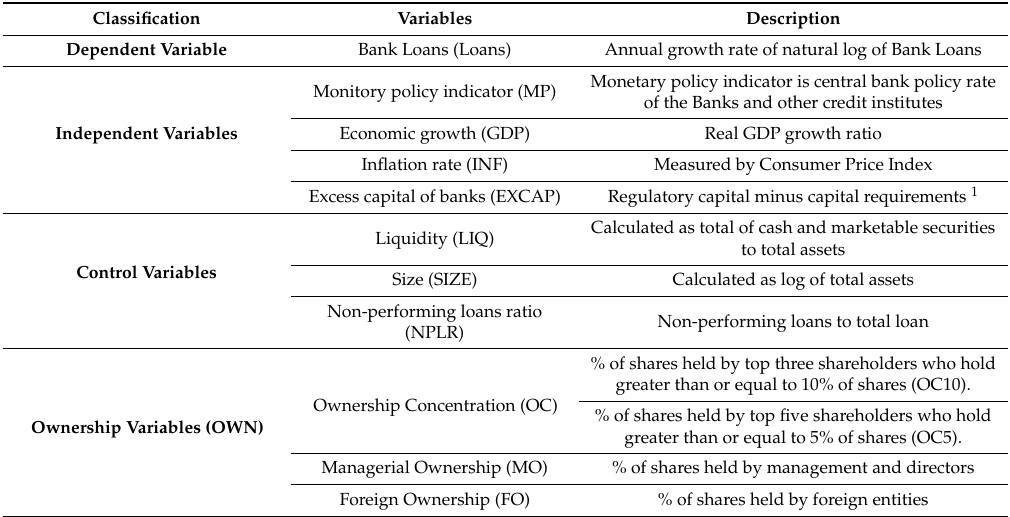
Table 1. Variables